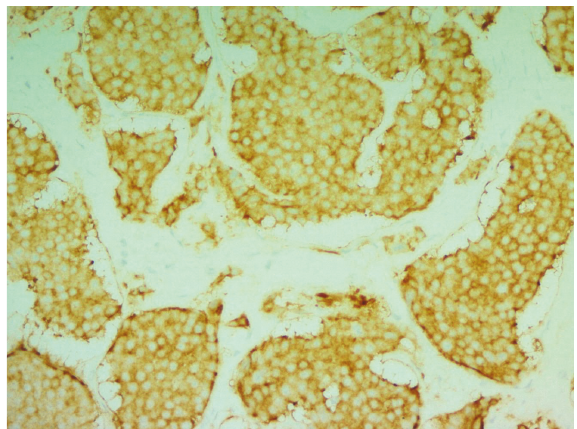
Figure 3: Synaptophysin immunohistochemical stain (cytoplasmic staining)